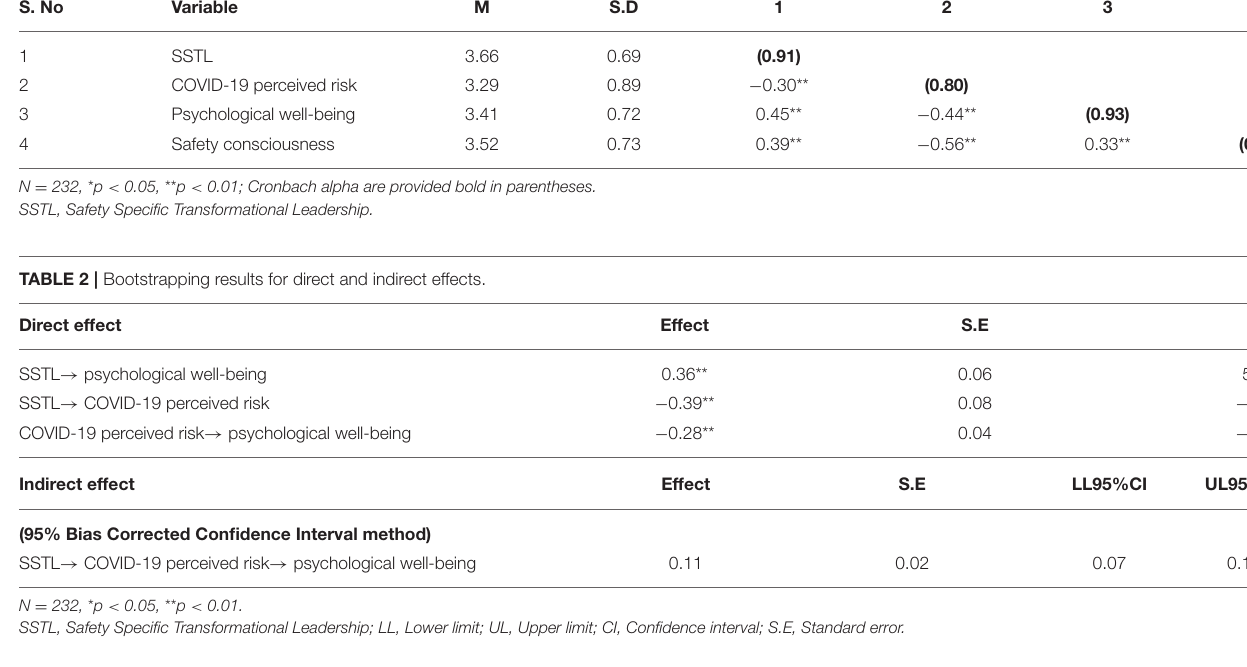
TABLE 1 | Mean, standard deviation, reliability, and correlation. S. No